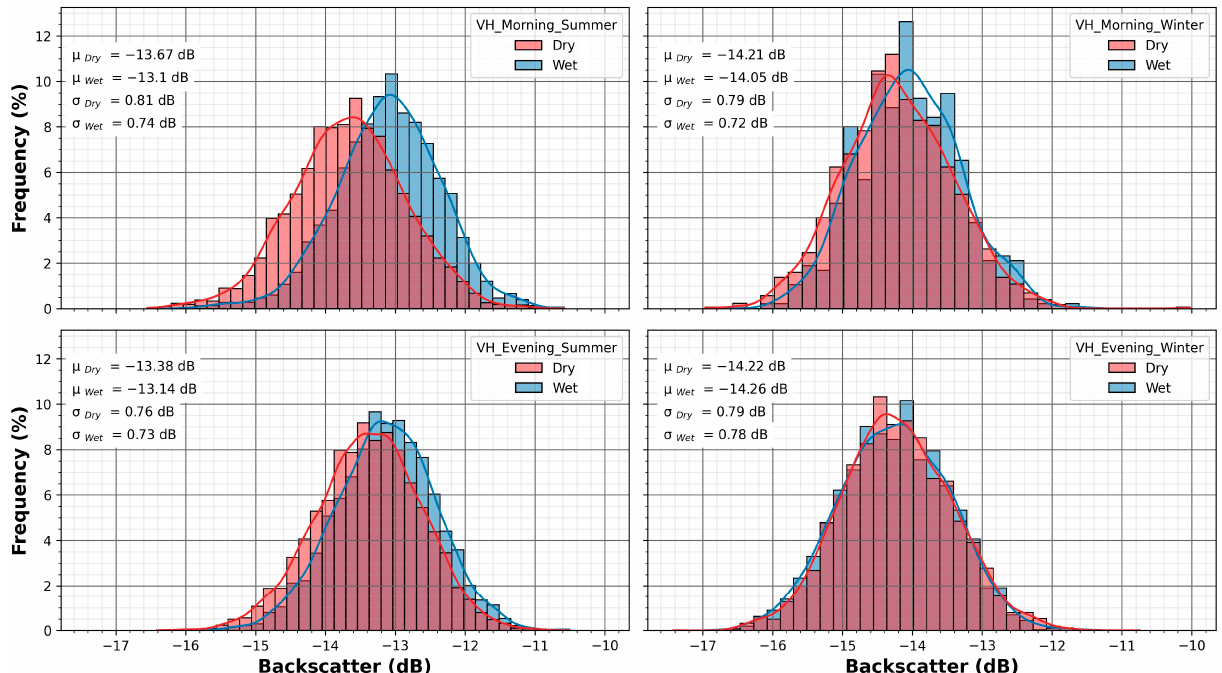
Figure 6. Distribution of VH backscatter by time of day and “dry” (2016, 2018, 2019) and “wet” (2017, 2021) years for summer (Jun–Aug) and winter (Nov–Jan). “Dry” and “Wet” are derived from the long-term precipitation since 1961.